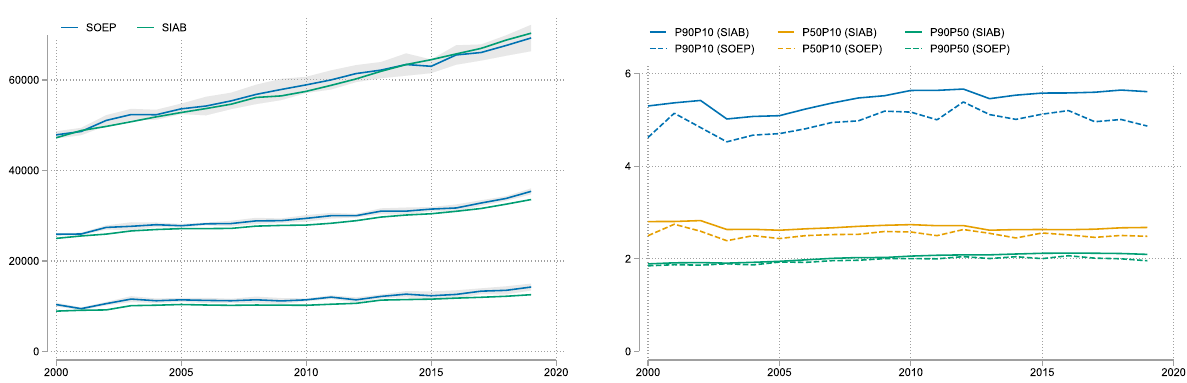
Fig. 6 Annual wages in 2000–2019; sample: comparable sample; only wages above marginal part-time employment ceiling. Source: own calculations, SOEP-Core.v37.EU & SIAB 7519. 95% confidence interval indicated by shaded areas (for percentiles only); 500 bootstrap